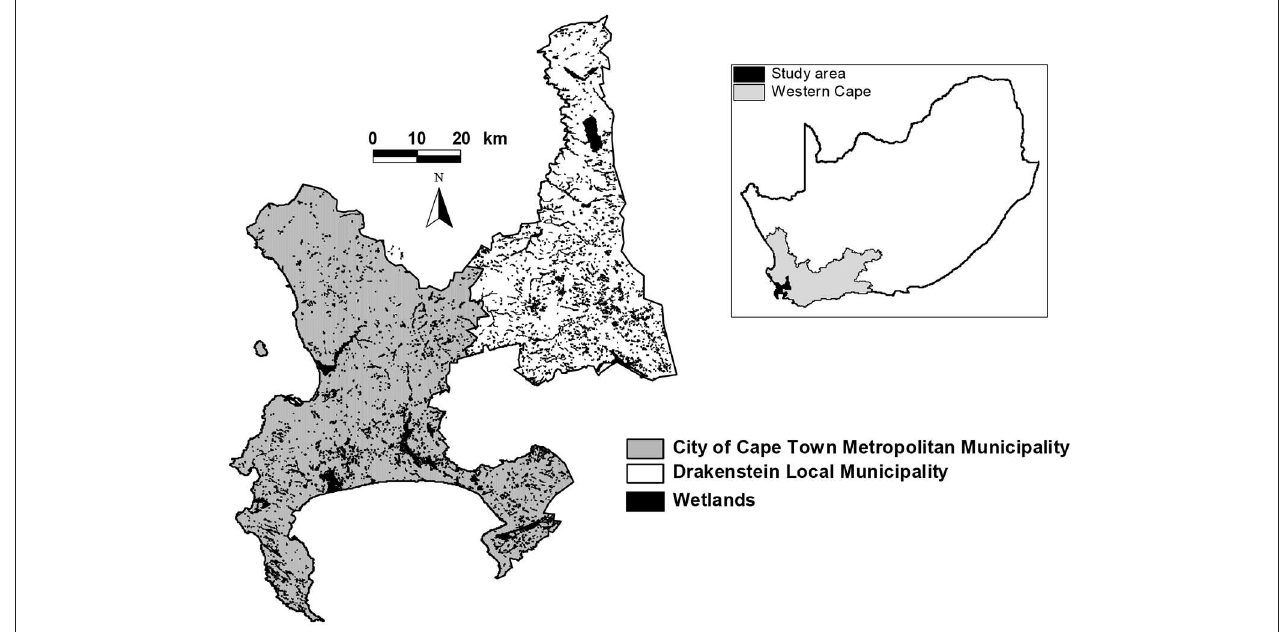
FIGURE 1 | Map of study area, showing City of Cape Town and Drakenstein municipalities and their respective wetlands datasets; inset shows context of study area within the Western Cape Province of South Africa.